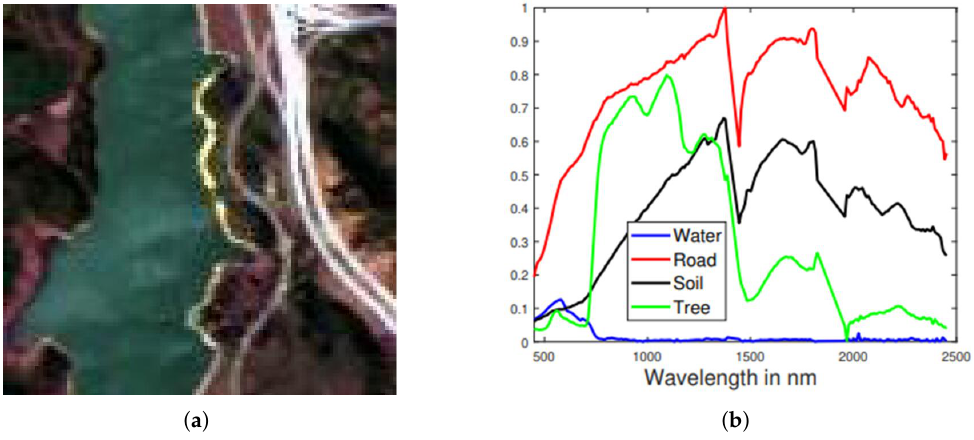
Figure 5. Jasper image: ( a ) Jasper color image (Red: 570.14 nm, Green: 532.11 nm, Blue: 427.53 nm) ( b ) Ground truth